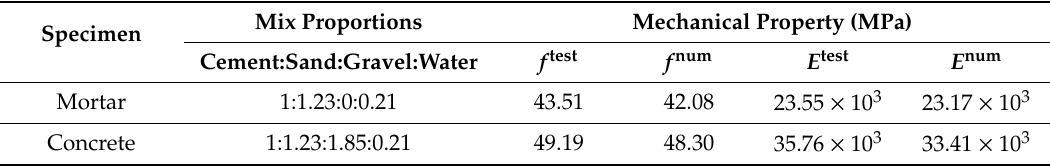
Table 3. Mix proportions and mechanical properties of the mortar and concrete.